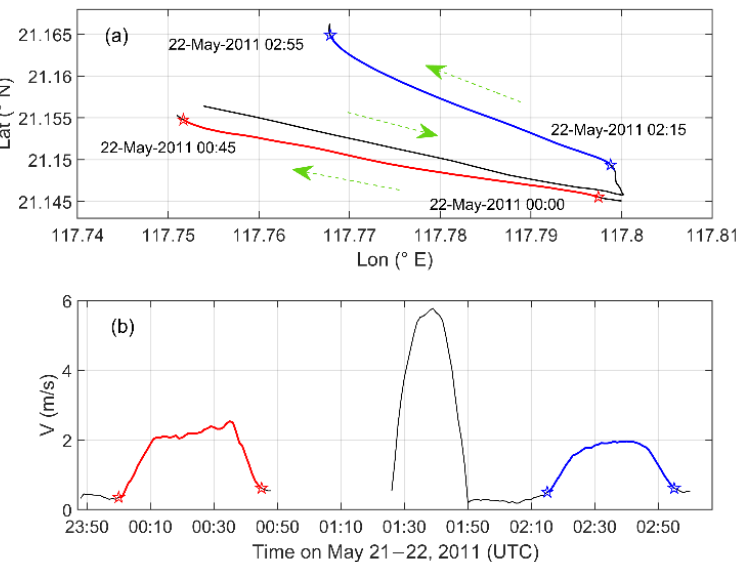
uncommonly large.